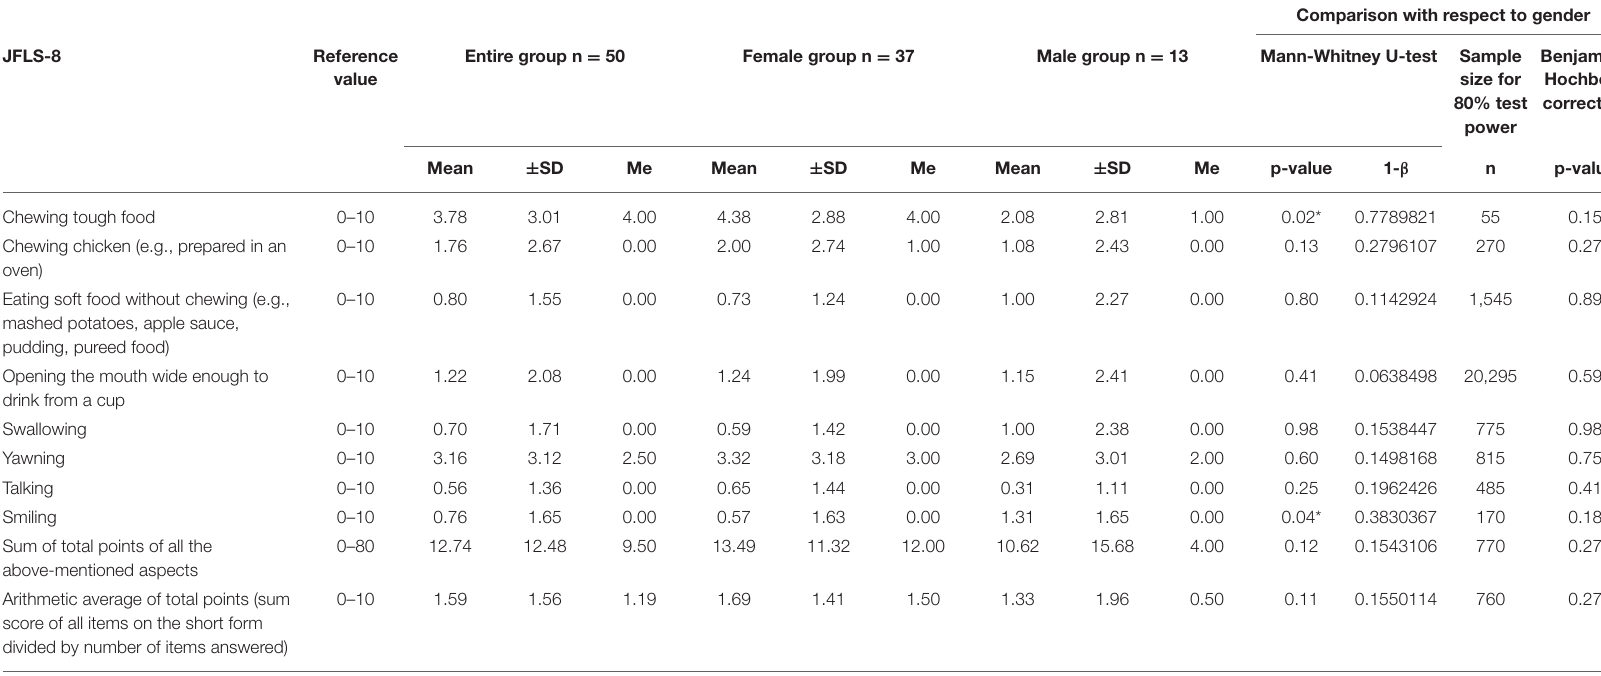
TABLE 1 | Jaw functional limitations with respect to JFLS-8 in the entire study group (n = 50), the female group (n = 37) and the male group (n = 13).